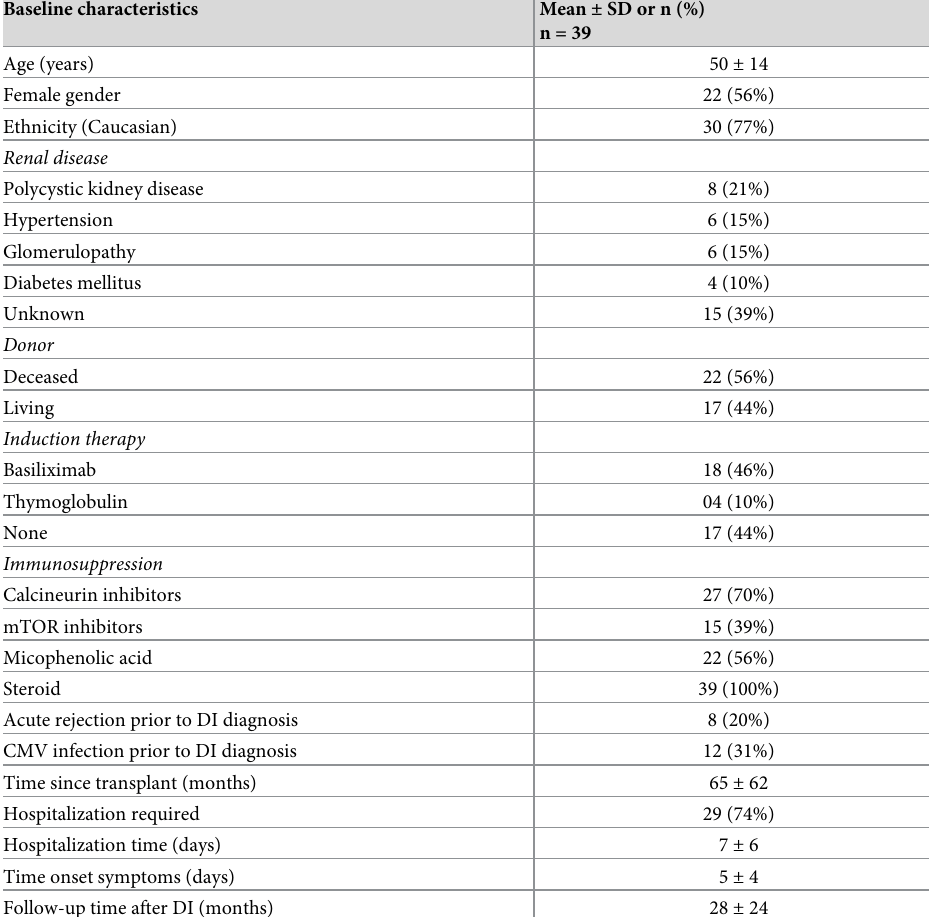
Table 1. Demographic characteristics of 39 transplant recipients at initial diagnosis of dengue infection. Baseline